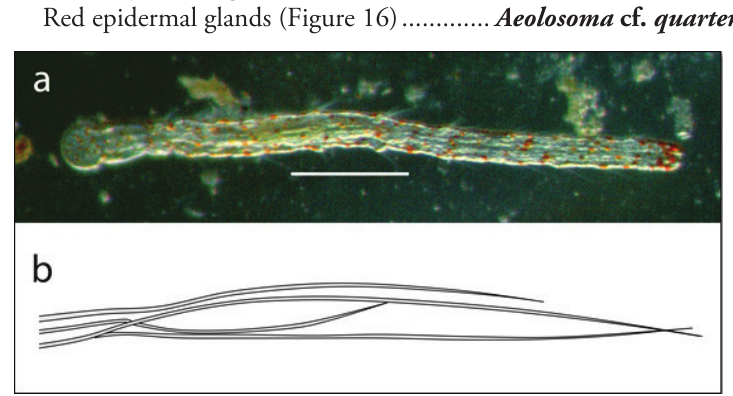
Figure 16. Aeolosoma cf. quarternarium : A photo of entire body showing red epidermal glands and disc- like anterior (scale 200 µm) B typical variable bundle of